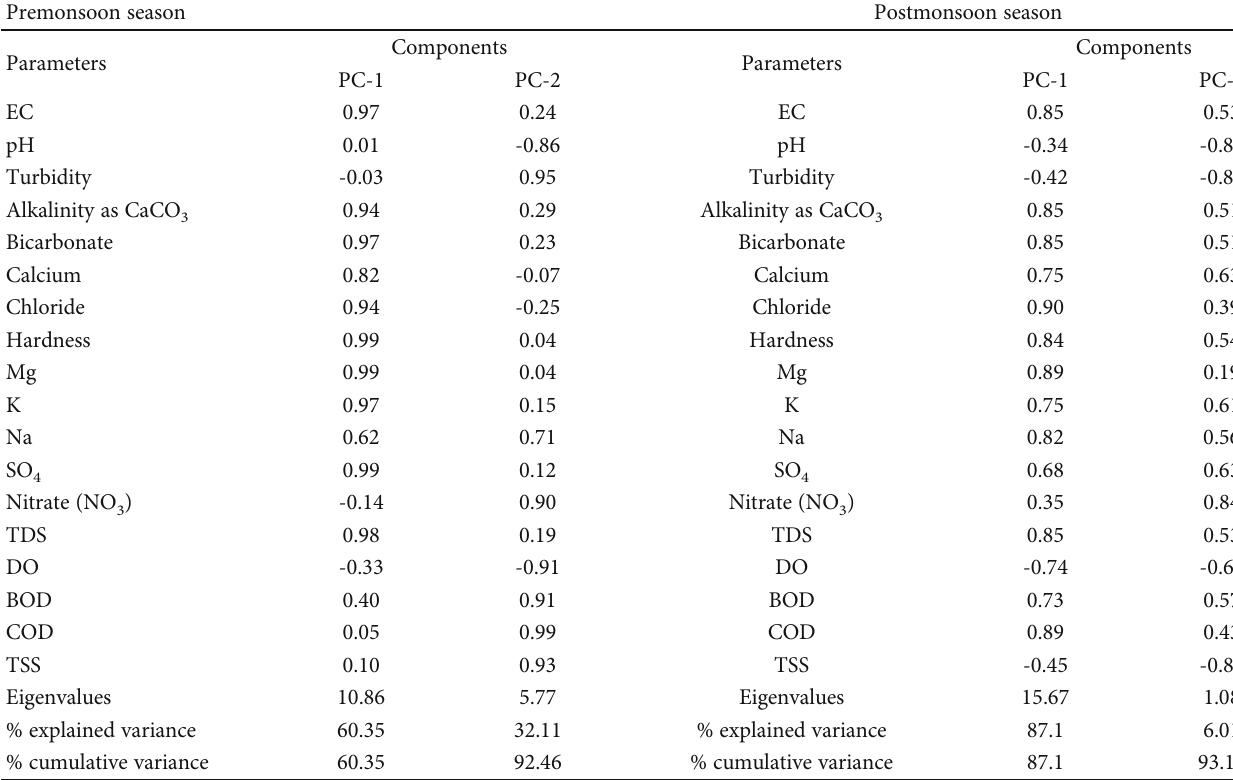
Table 5: Principal components, loading factors, eigenvalues, and